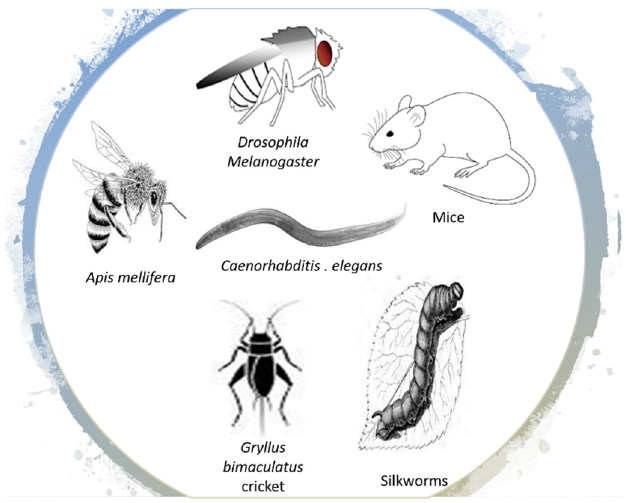
Figure 2. Royal jelly and its components improve healthspan and extend lifespan in different species.